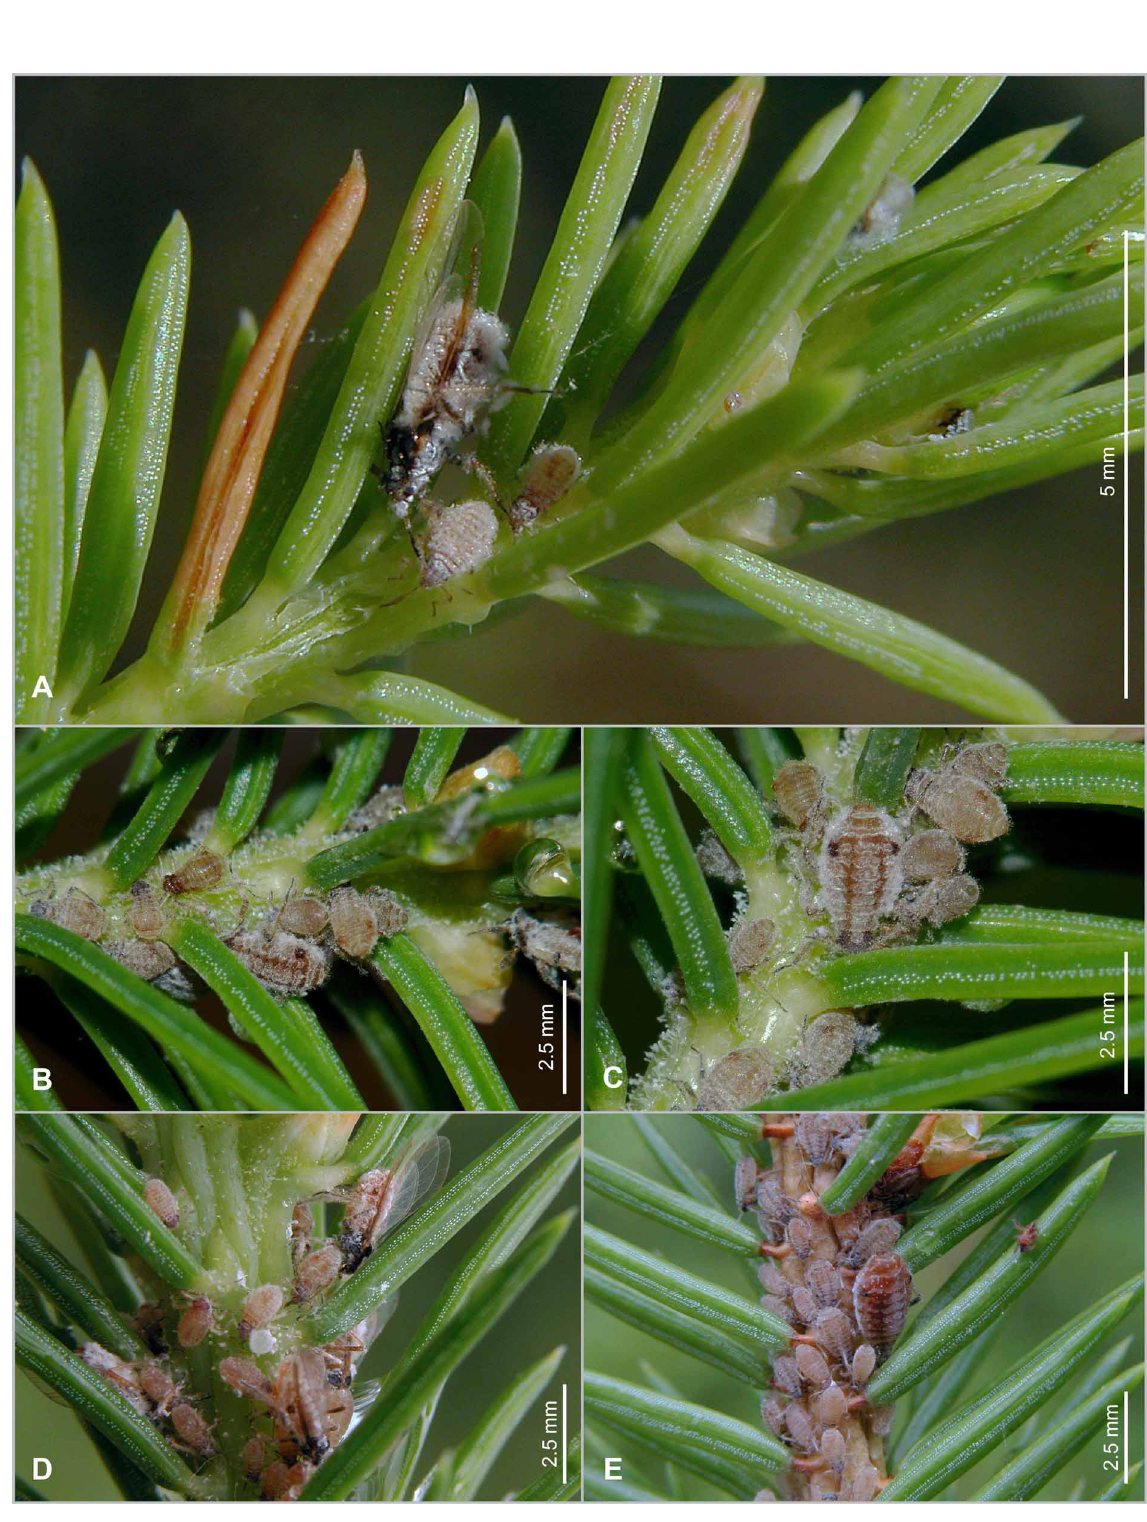
Fig. 31. Cinara (Cinara) pilicornis (Hartig, 1841). Newly founded colonies on young shoots of Picea abies . Wax cover intact and pattern very distinct. Note the thick wax wool on the alatae (A,